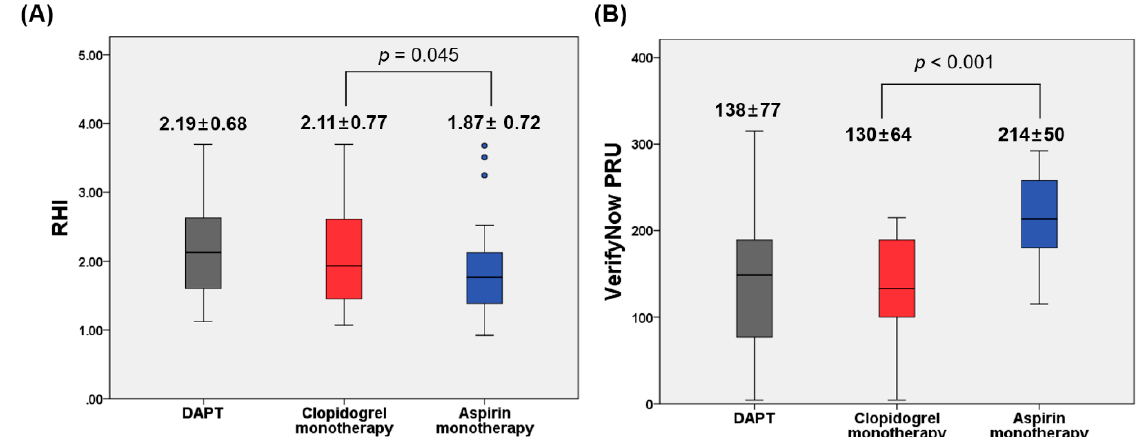
Figure 2. EndoPAT ( A ) and VerifyNow assay ( B ) according to antiplatelet regimen. The central box represents the values between the lower and upper quartiles, and the middle line is the median. The vertical line extends from the minimum to the maximum value, excluding outside values, which are displayed as separate points. PRU, P2Y12 Reaction Units; RHI, reactive hyperemia index. Table 3. Vascular function and hemostatic measurement. AI, augmentation index; ASP, aspirin; CLPD, clopidogrel; DAPT,